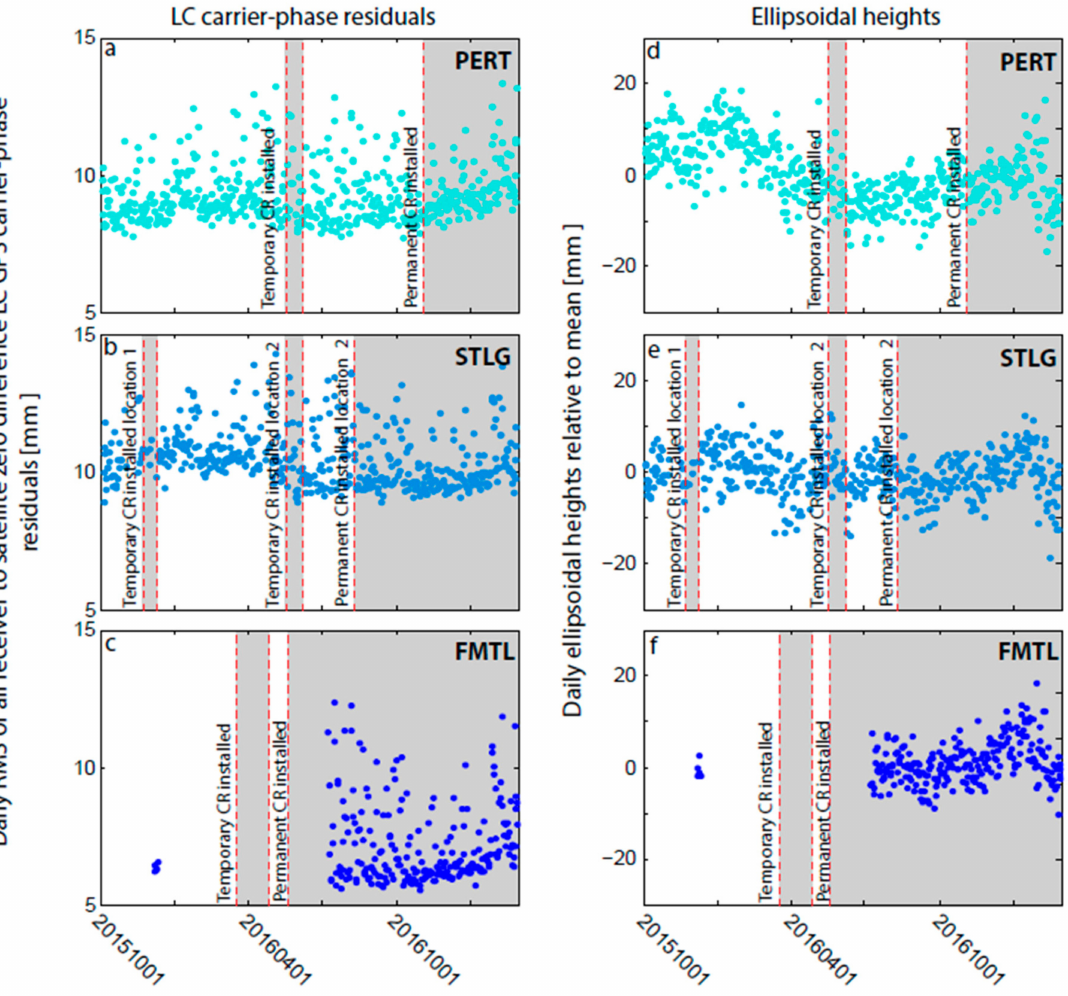
Figure 4. ( a – c ) Daily RMS of all receiver to satellite zero-difference ionosphere-free